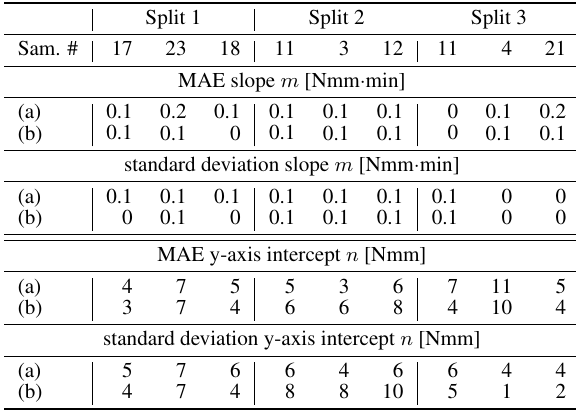
Figure 5. Correlation of the determined regression parameters. Each point represents one